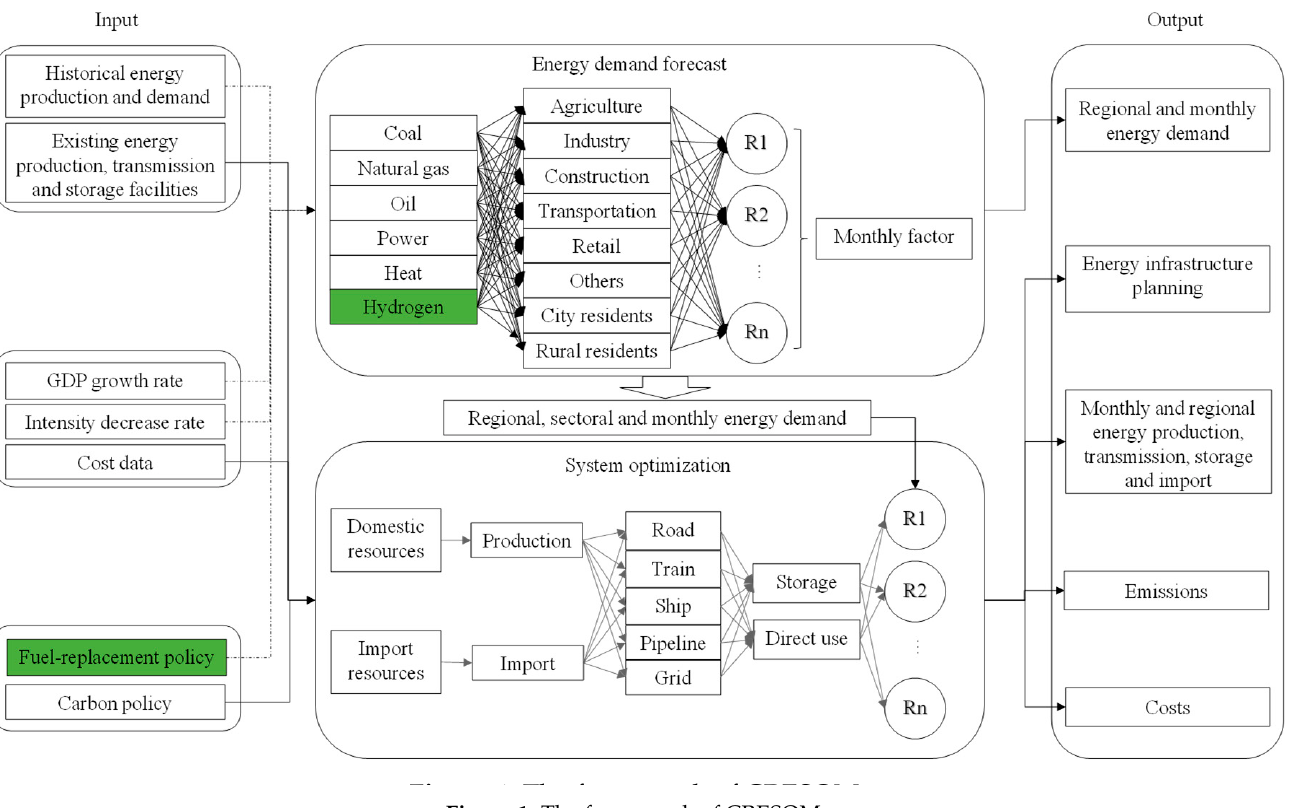
Figure 1. The framework of CRESOM.